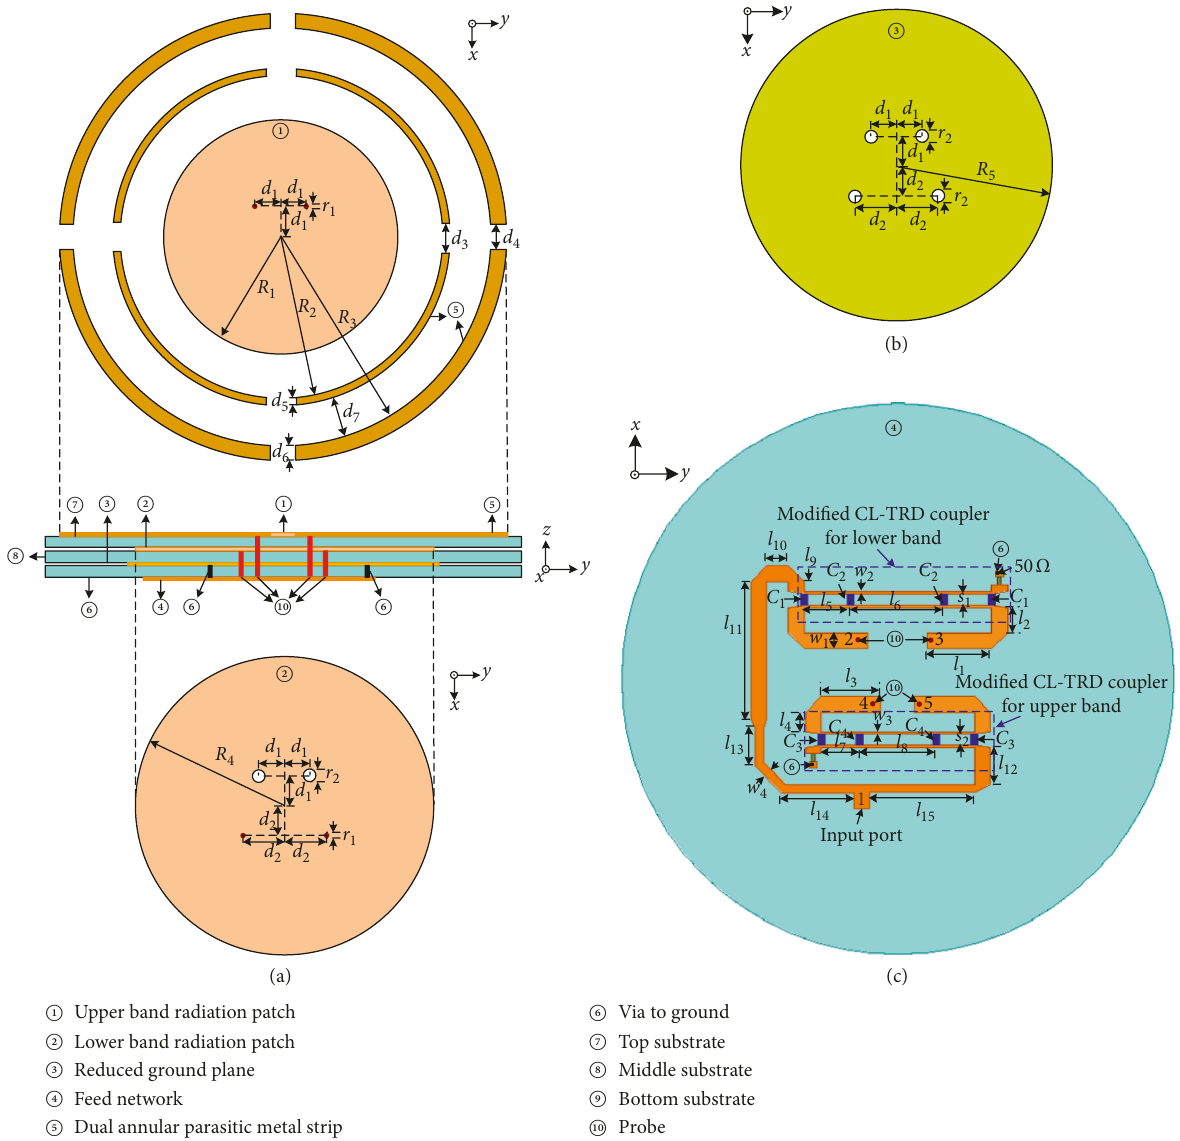
Figure 1: Geometry of the proposed dual-band antenna. (a) Radiation patches with D-APMS. (b) R-GP. (c) Feed network. Table 1: Dimension parameters of the proposed antenna (unit: mm and